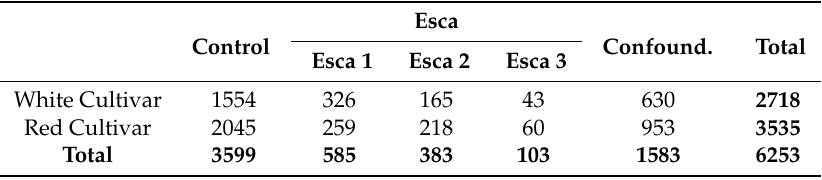
Table 1. Summary of image database samples: Number of 224 × 224 patches per class.